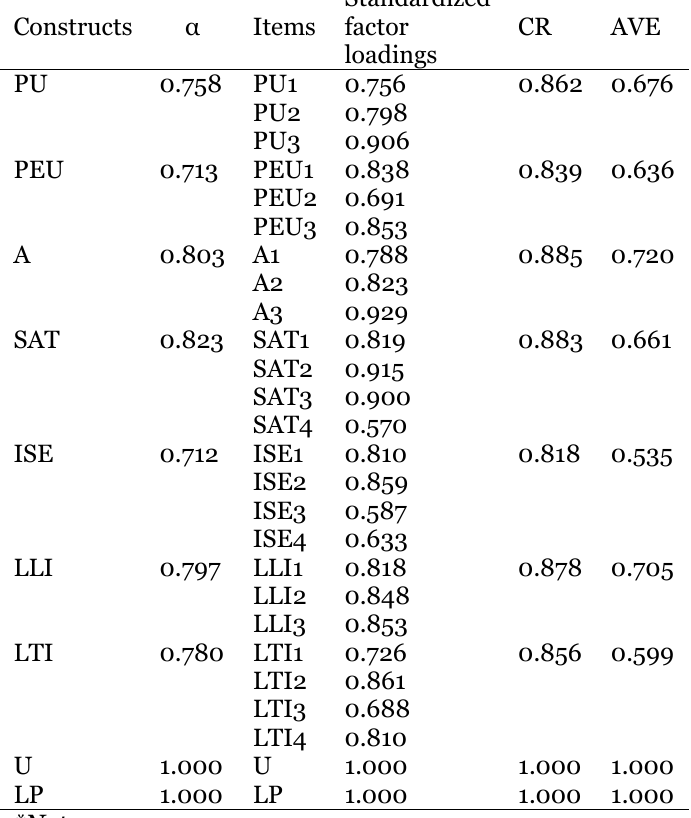
The Characteristics of Constructs and